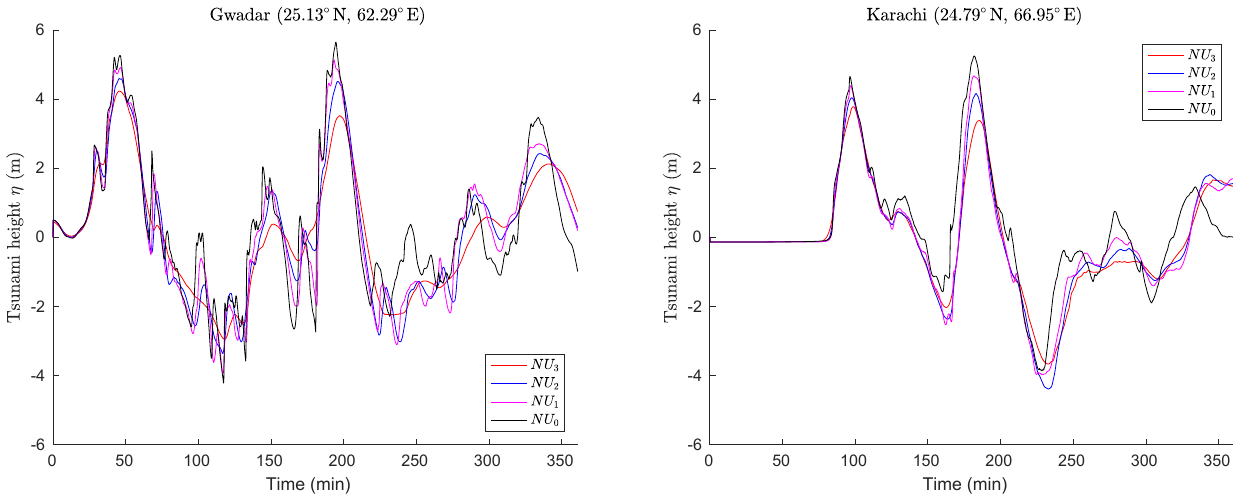
Figure 8. Tsunami waveforms at virtual gauges located at Gwadar and